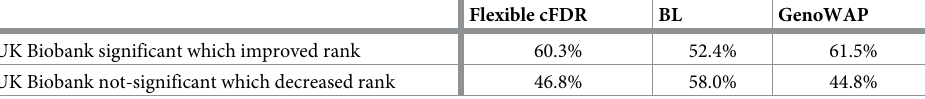
Table 2. Summary of SNP-level results when leveraging GenoCanyon scores with asthma GWAS p -values. Table lists the percentage of the 5152 FDR significant SNPs in UK Biobank which improved rank (“UK Biobank signif- icant which improved rank”) and the percentage of the 1,963,499 SNPs that were not FDR significant in UK Biobank which decreased rank (“UK Biobank not-significant which decreased rank”) after applying Flexible cFDR, BL or GenoWAP. Flexible cFDR BL GenoWAP UK Biobank significant which improved rank 60.3% 52.4% 61.5% UK Biobank not-significant which decreased rank 46.8%